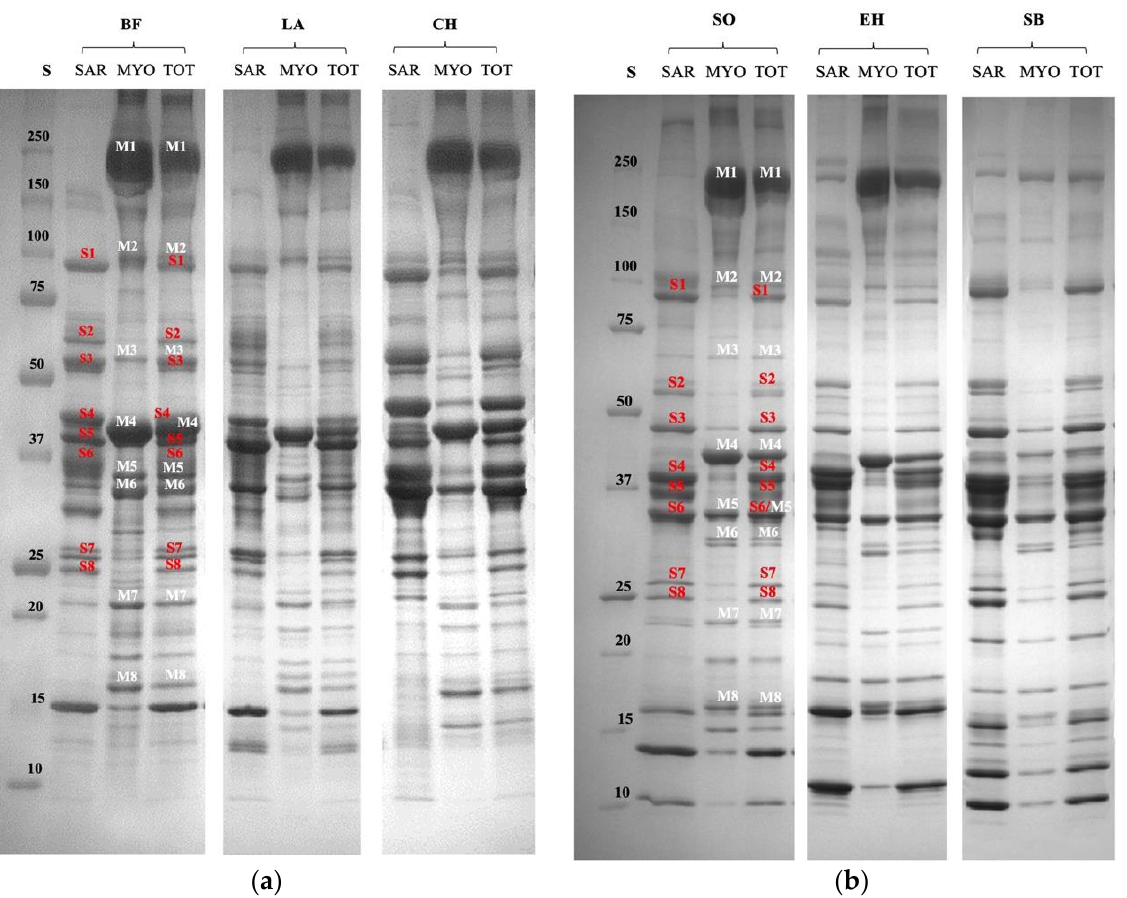
Figure 1. Gradient (8 – 18%) SDS-PAGE gel of myofibrillar (MYO), sarcoplasmic (SAR), and total (TOT) protein fractions extracted from beef (BF), lamb (LA), and chicken (CH) meat samples ( a ); and sole (SO), European hake (EH), and sea bass fish (SB) meat sources ( b ). M1 = myosin heavy chain; M2 = α -actinin; M3 = desmin; M4 = actin; M5 = troponin T; M6 = tropomyosin; M7 = myosin light chain 1; M8 = myosin light chain 2; S1 = glycogen phosphorylase b kinase; S2 = phosphoglucomutase; S3 = phosphoglucose isomerase; S4 = enolase; S5 = creatine kinase; S6 = glyceraldehyde phosphate dehydrogenase; S7 = phosphoglycerate mutase; S8 = triosephosphate isomerase.